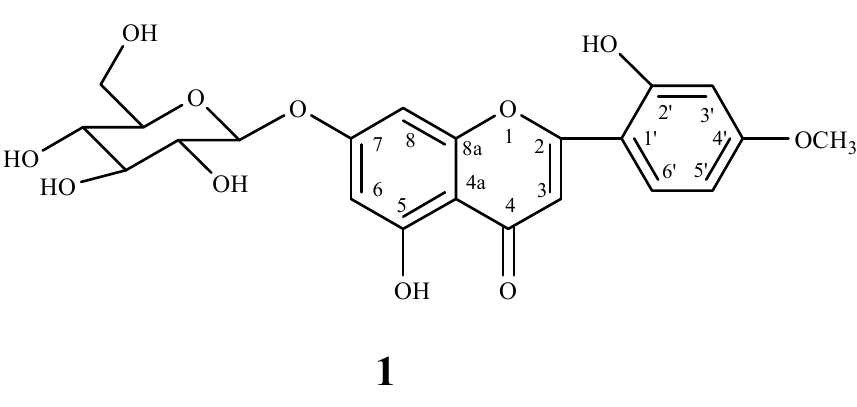
Figure 1. Chemical structure of compound 1 .